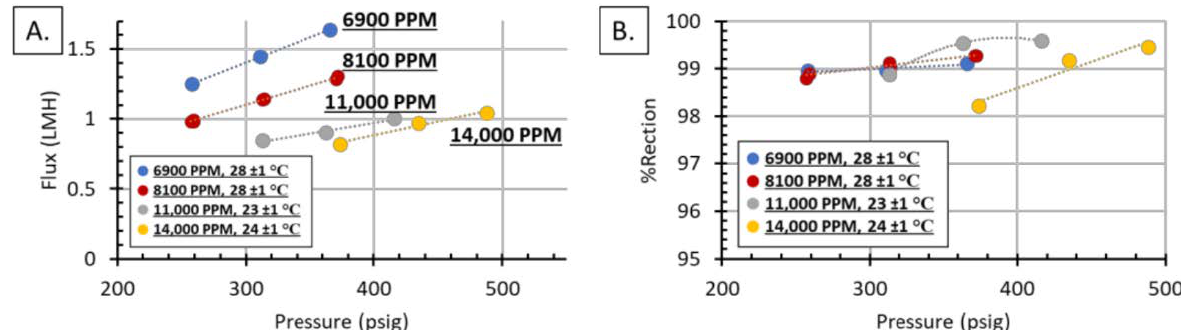
Figure 6. ( A ) Flux as a function of pressure for diluted FGD wastewater. Flux increased linearly with pressure, and flux decreased with increasing concentration. ( B ) %Rejection as a function of pressure.